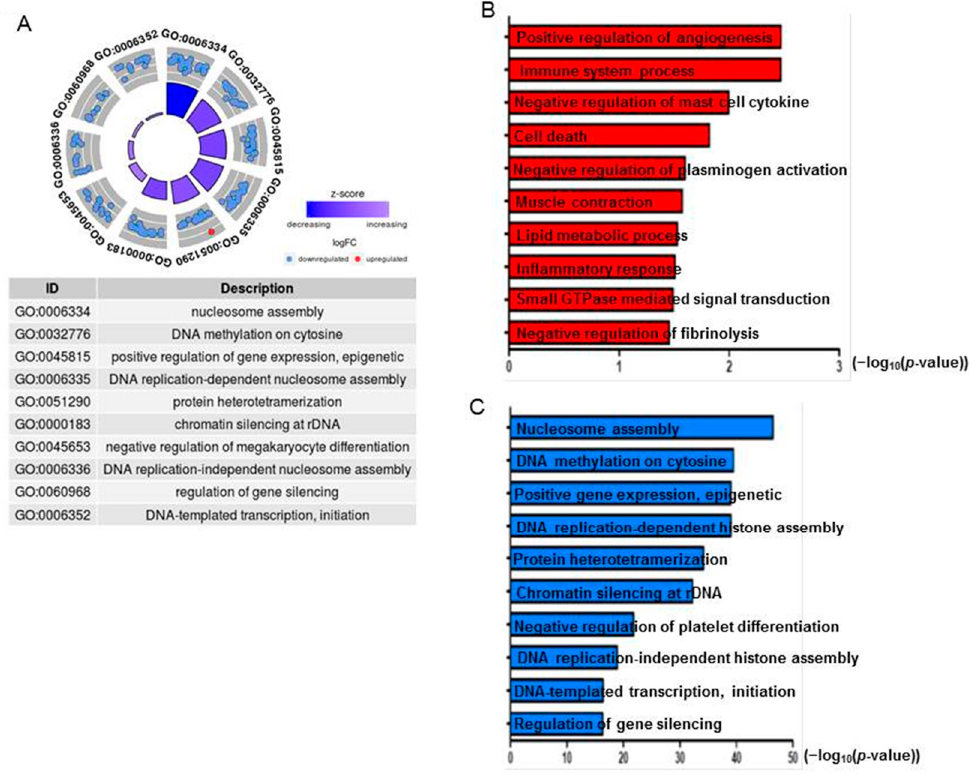
Figure 12. The altered gene expression is associated with apoptosis and nucleosome assembly. ( A ) gene ontology (GO) term analysis using both up- and downregulated genes together. ( B ) GO term analysis using downregulated genes only. ( C ) GO term analysis using upregulated genes only; − log 10 ( p -value) is indicated on the x-axis.